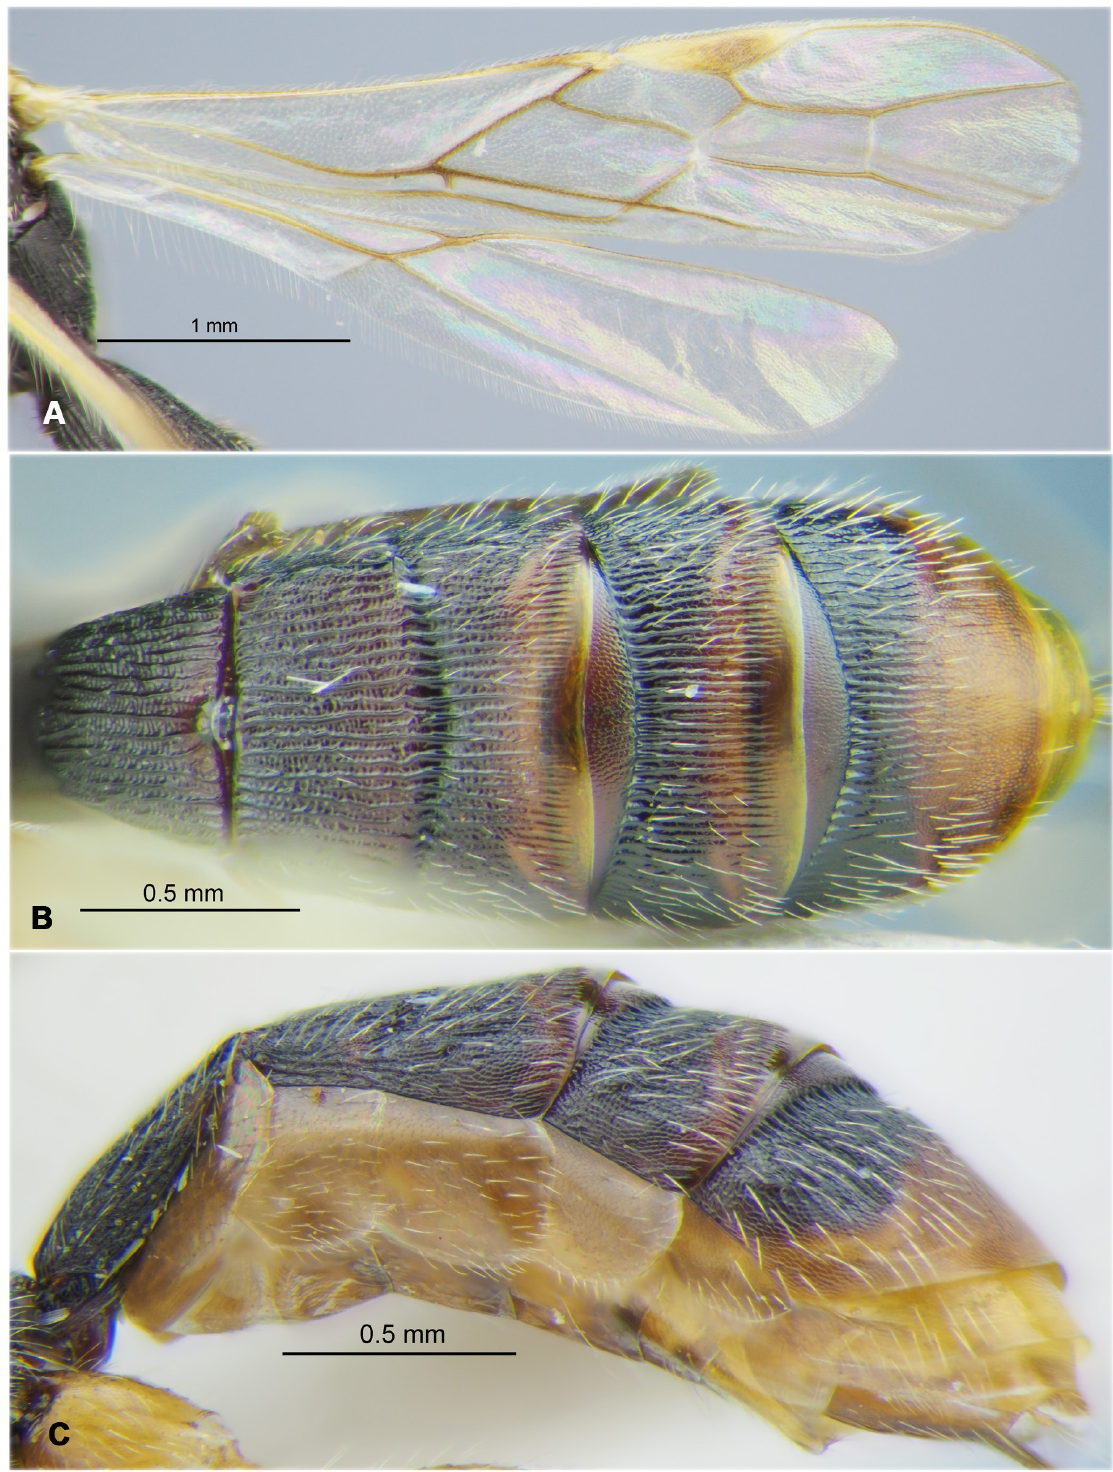
Fig. 60. Rhaconotus ( Rh. ) sudanensis Wilkinson, 1927, ♀ (RMNH). A . Wings. B . Metasoma, dorsal view. C . Metasoma, lateral